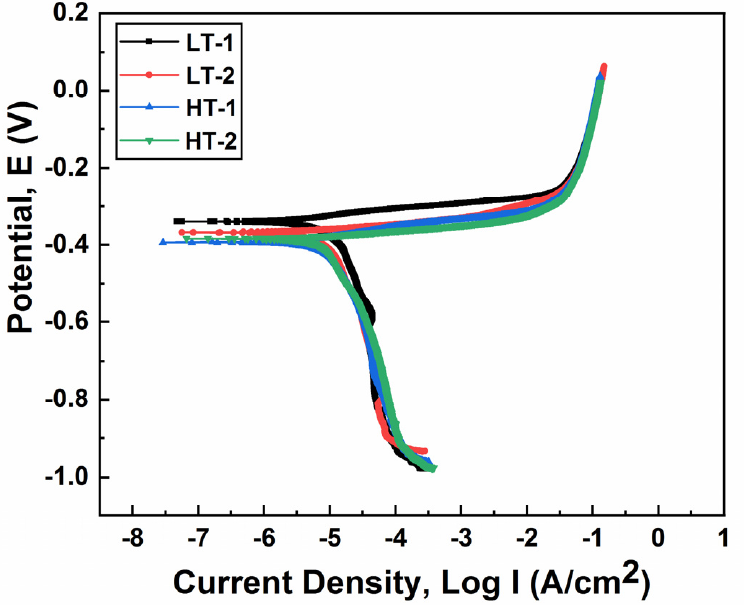
Figure 13. Potentiodynamic polarization curves of ballistic steel samples in 3.5 wt.% NaCl solu- tion.